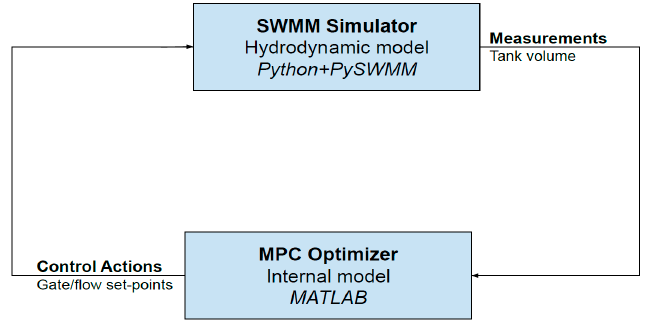
Figure 2. The closed-loop Real-Time Control (RTC) scheme.